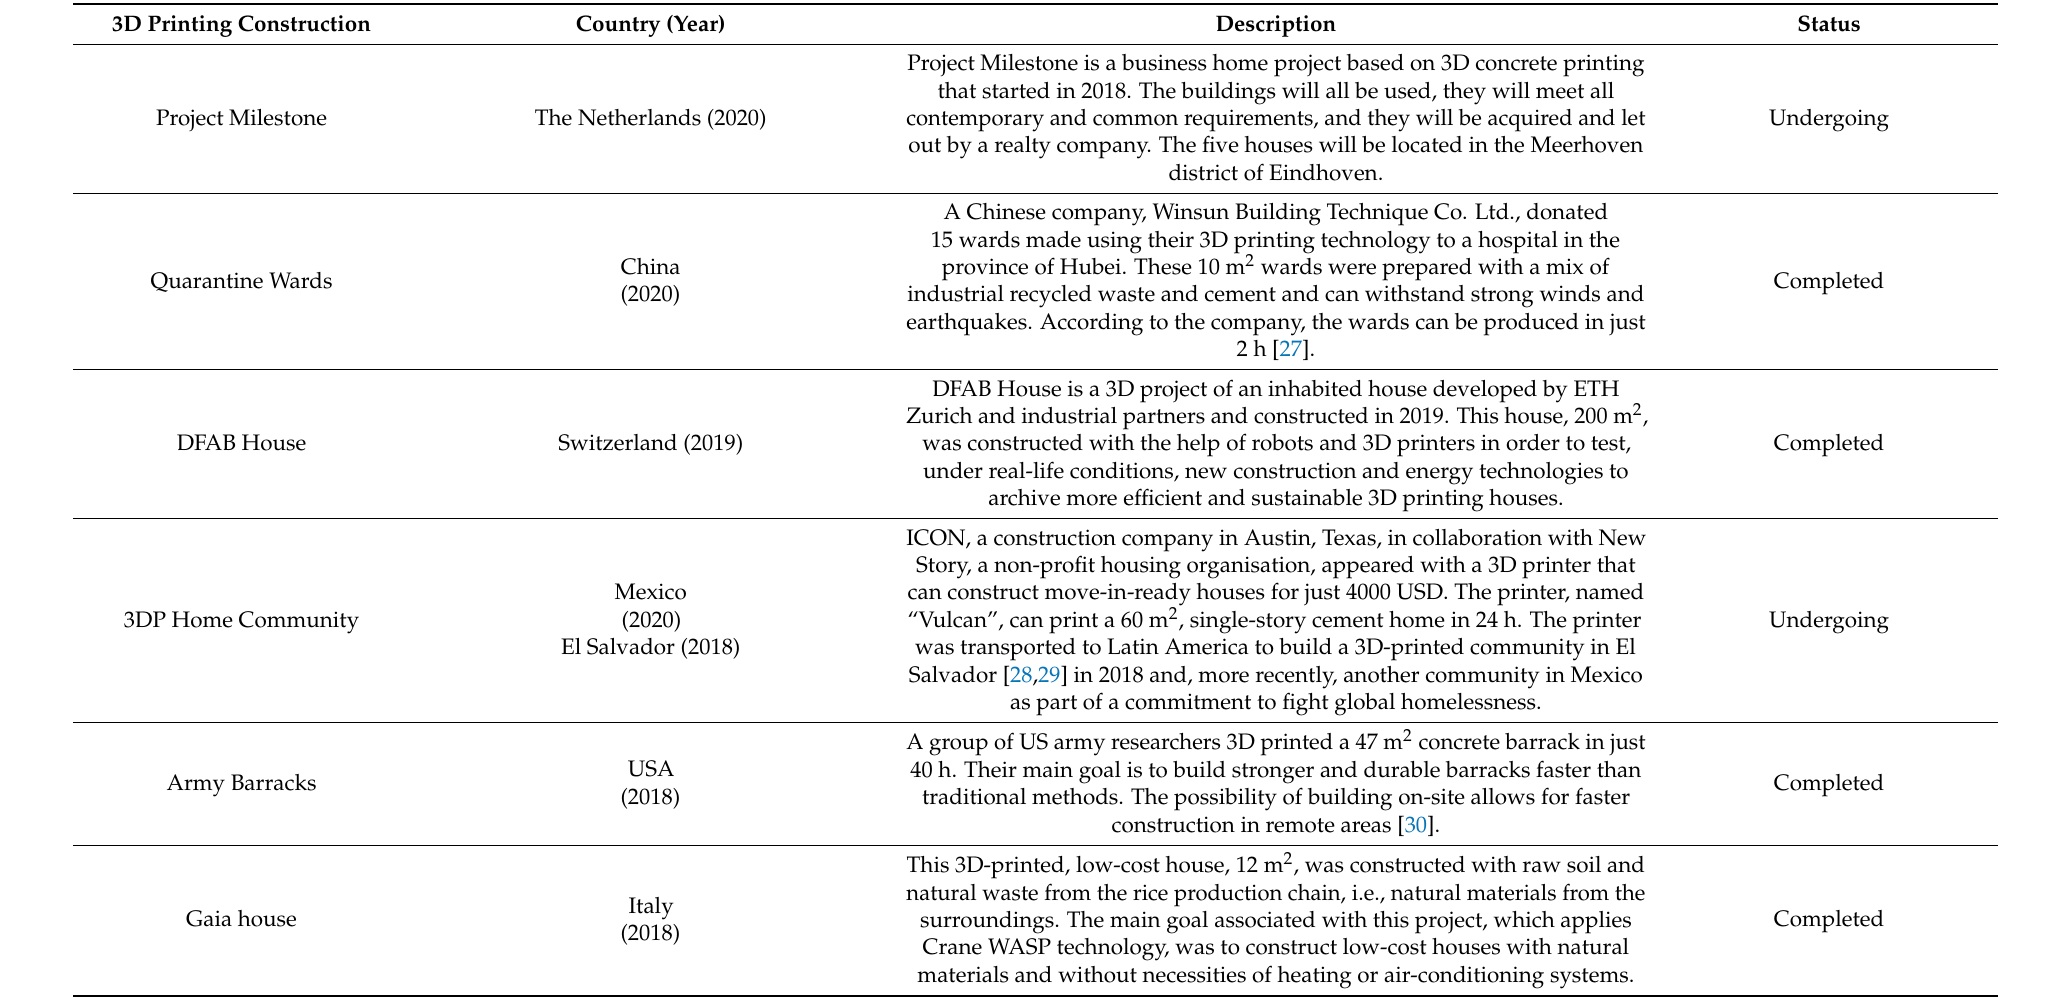
Table 1. Examples of civil engineering constructions using 3D